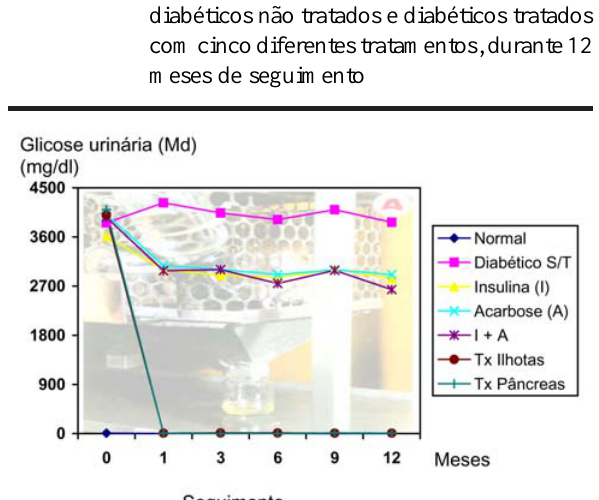
FIGURA 7 - Medianas da glicose urinária (mg/dl) de animais normais, diabéticos não tratados e diabéticos tratados com cinco diferentes tratamentos,